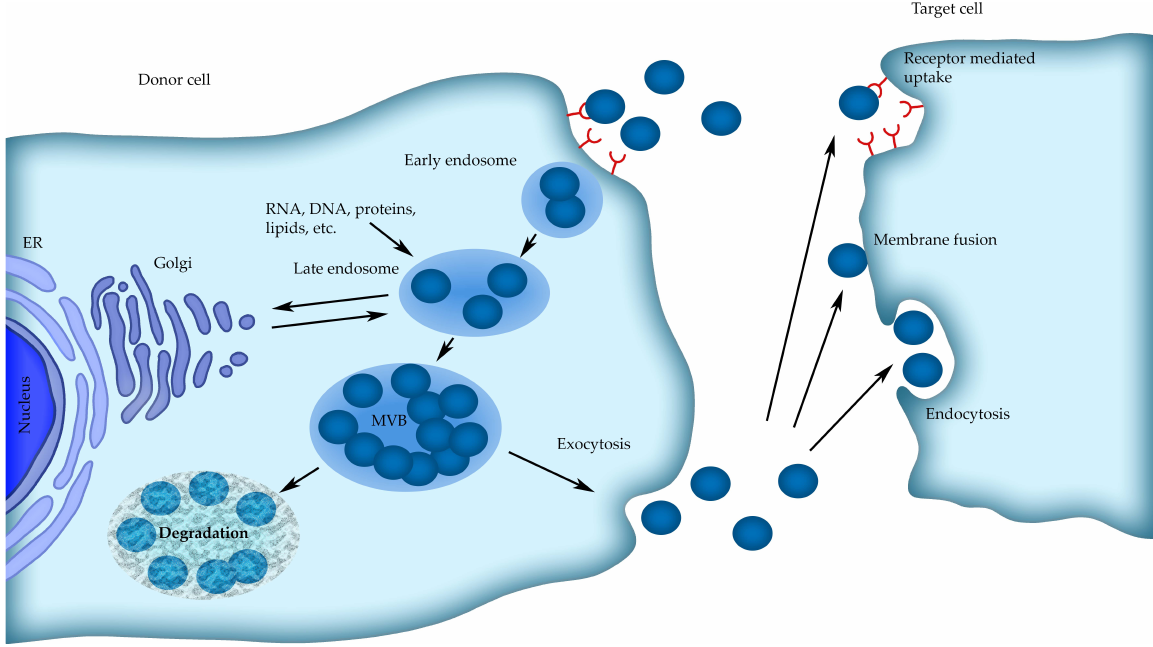
Figure 1. Scheme of the exosomes formation, release, and internalization by